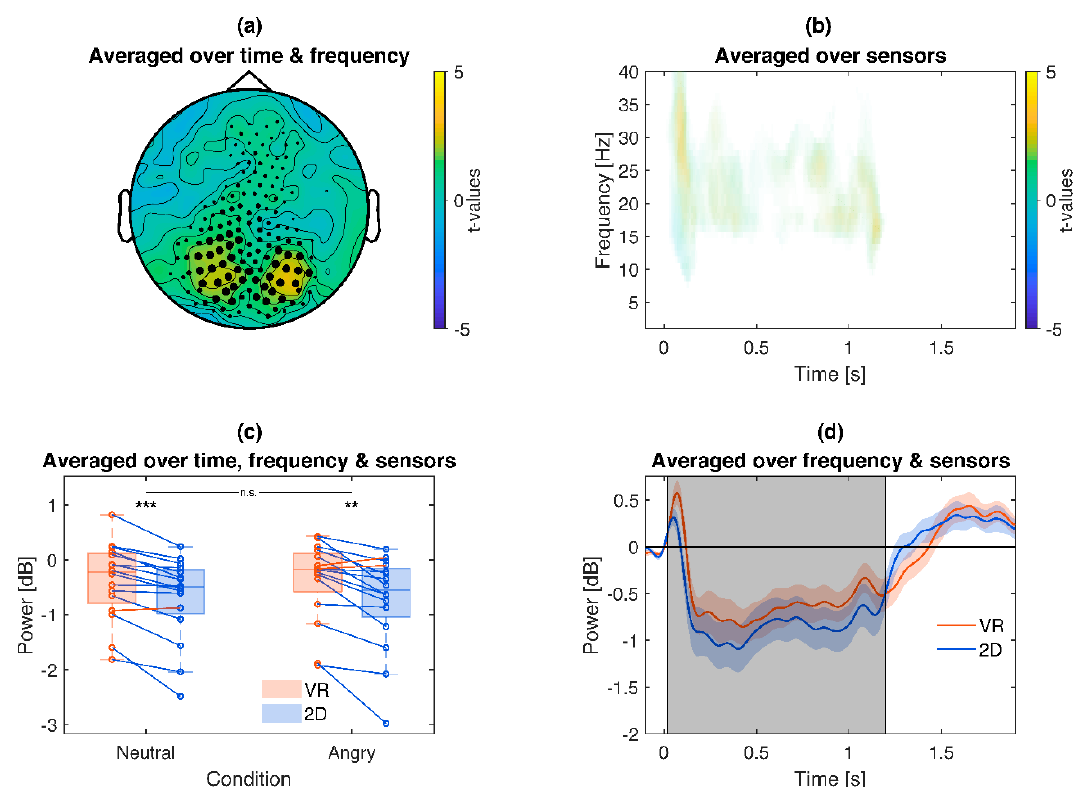
Figure 6. Illustration of the VR vs. 2D frequency cluster (baseline corrected): VR stimulation leads to overall weaker beta-ERD. ( a ): Topography of t -values averaged across the significant time points and frequency bins. ( b ): Time-frequency plot of t -values, averaged across sensors of the respective cluster. Only time-frequency bins which are part of the cluster are displayed. ( c ): Box plot and single subject values from the cluster. Blue lines indicate a weaker ERD for VR compared to 2D conditions, red the opposite. Asterisks indicate the significance of exploratory post-hoc group comparisons: *** p < 0.001, ** p < 0.01, ns p > 0.05. ( d ): Time course of the cluster. Colored shaded areas signify standard errors. Grey shaded areas signify the latency of the cluster.